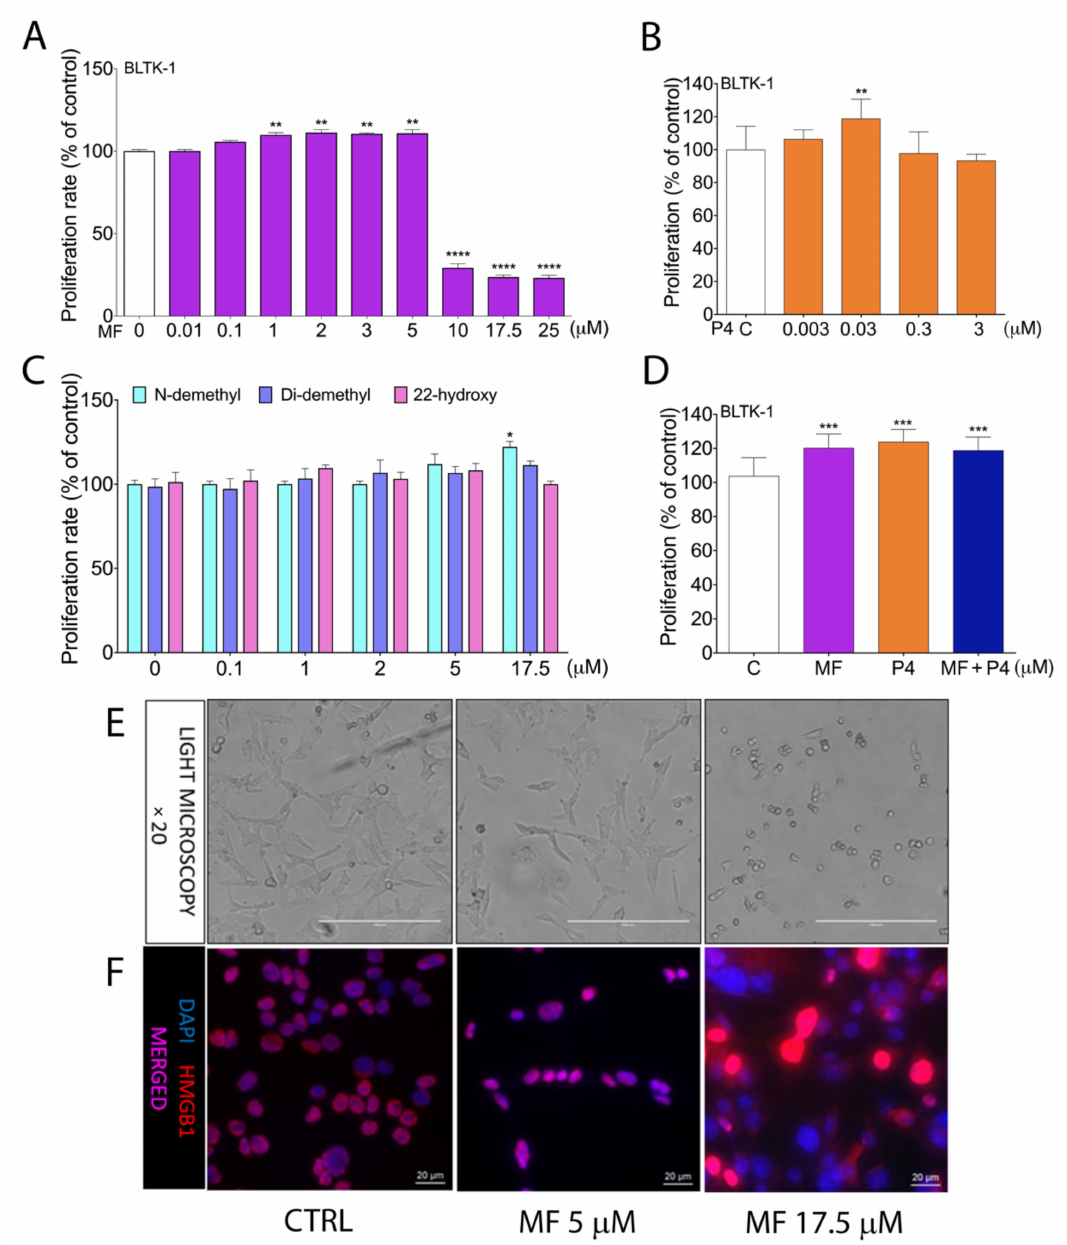
Figure 1. Proliferation of BLTK-1 cells with MF, P4 or MF metabolite treatments. E ff ects of MF ( A ), P4 ( B ), the 22-hydroxy, N-demethyl and Di-demethyl MF metabolites ( C ) and MF with P4 ( D ) on BLTK-1 cells proliferation after 72 h treatments, measured by MTT and BrdU assay. Light microscopy images of BLTK-1 cells after 5 µ M or 17.5 µ M MF treatment ( E ). Immunolocalization of HMGB1 protein after 5 µ M or 17.5 µ M MF treatment of BLTK-1 cells ( F ). The proliferation level of the treated groups is presented as the percentage of control proliferation, considered as 100%. Asterisks indicate significant di ff erences between the control and treated groups (*, p < 0.05; **, p < 0.01; ***, p < 0.001; ****, p < 0.0001.). Scale bar, 20 µ m. Di-demethyl MF, (11 β ,17 β )-11-(4-Aminophenyl)-17-hydroxy-17-(1-propyn-1-yl)-estra-4,9-dien-3-one; 22-hydroxy MF, (11 β ,17 β )-11-[4-(Dimethylamino)phenyl]-17-hydroxy-17-(3-hydroxy-1-propyn-1-yl)-estra-4,9-dien-3-one; Inh α / Tag mice; transgenic mice expressing the SV40 Taq oncogene under the inhibin α promoter; MF, mifepristone; N-demethyl MF, (11 β ,17 β )-17-Hydroxy-11-[4-(methylamino)phenyl]-17-(1-propyn-1-yl)- estra-4,9-dien-3-one; P4,